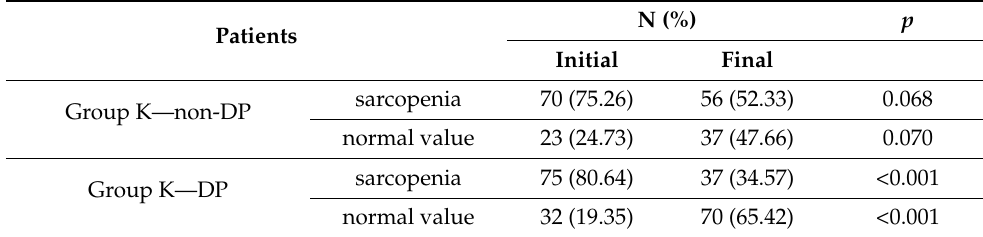
Table 3. Grouping of subjects according to the SMI.